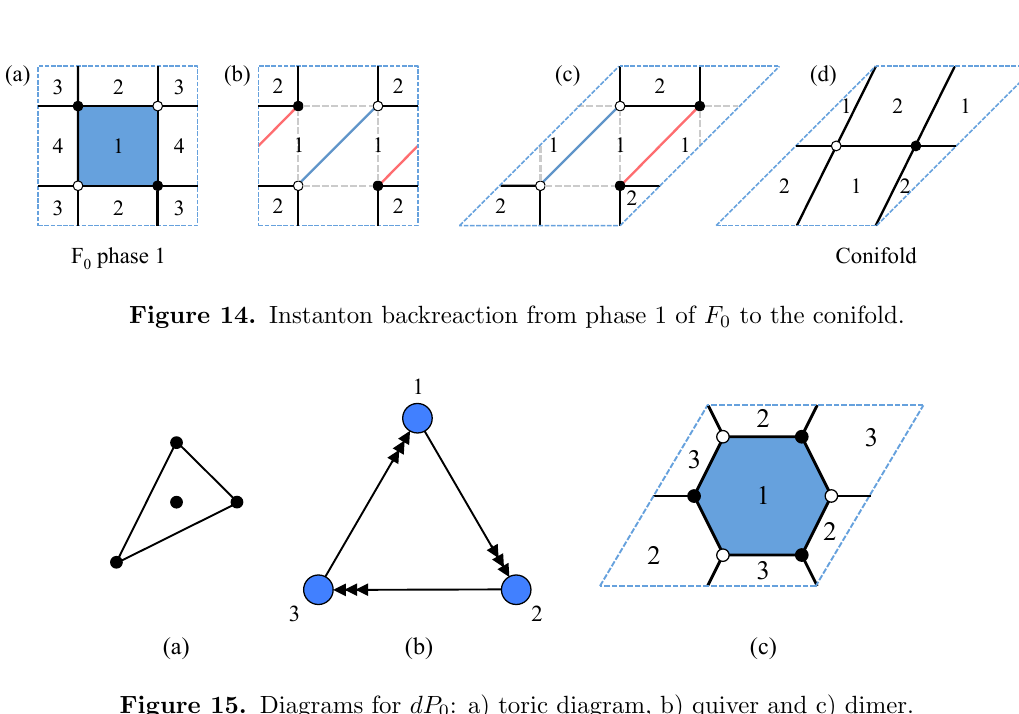
Figure 15. Diagrams for dP 0 : a) toric diagram, b) quiver and c)